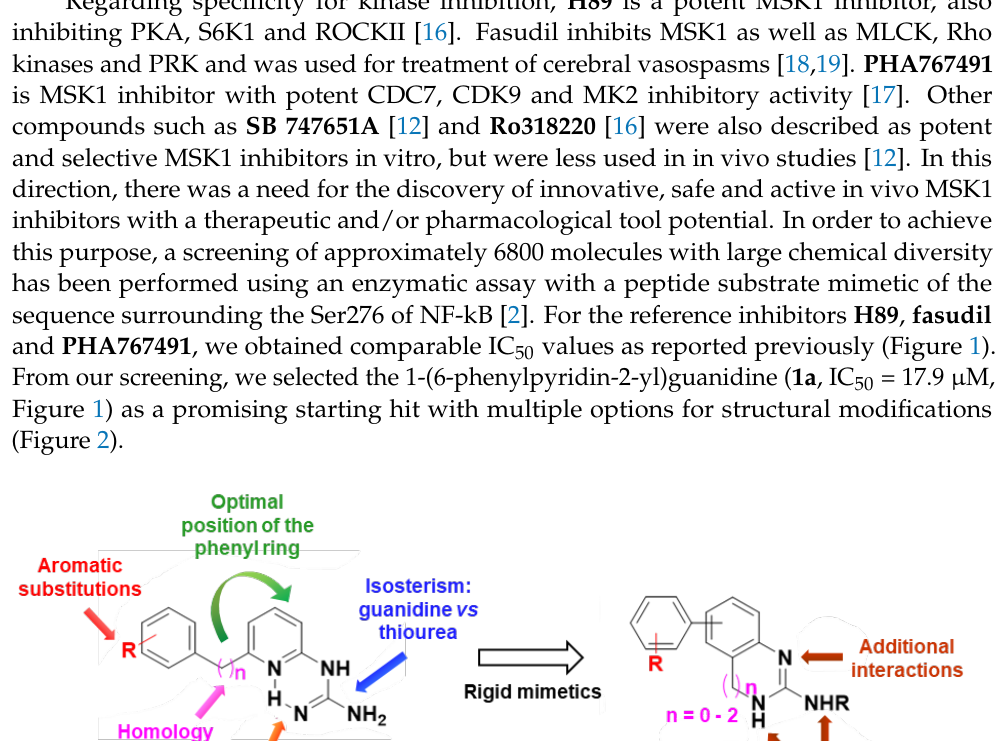
Figure 1. MSK1 inhibitors. Chemical structures and IC 50 values of three of the most common MSK1 inhibitors, H89 , fasudil and PHA767491 , and of the compound 1a , selected hit from an enzymatic screening.